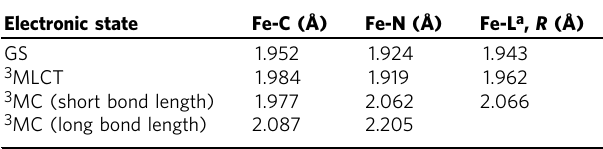
Table 1 Calculated distances between Fe and the coordinating atoms in the relevant [Fe(bmip) 2 ] 2 + electronic states from ref. 46 .